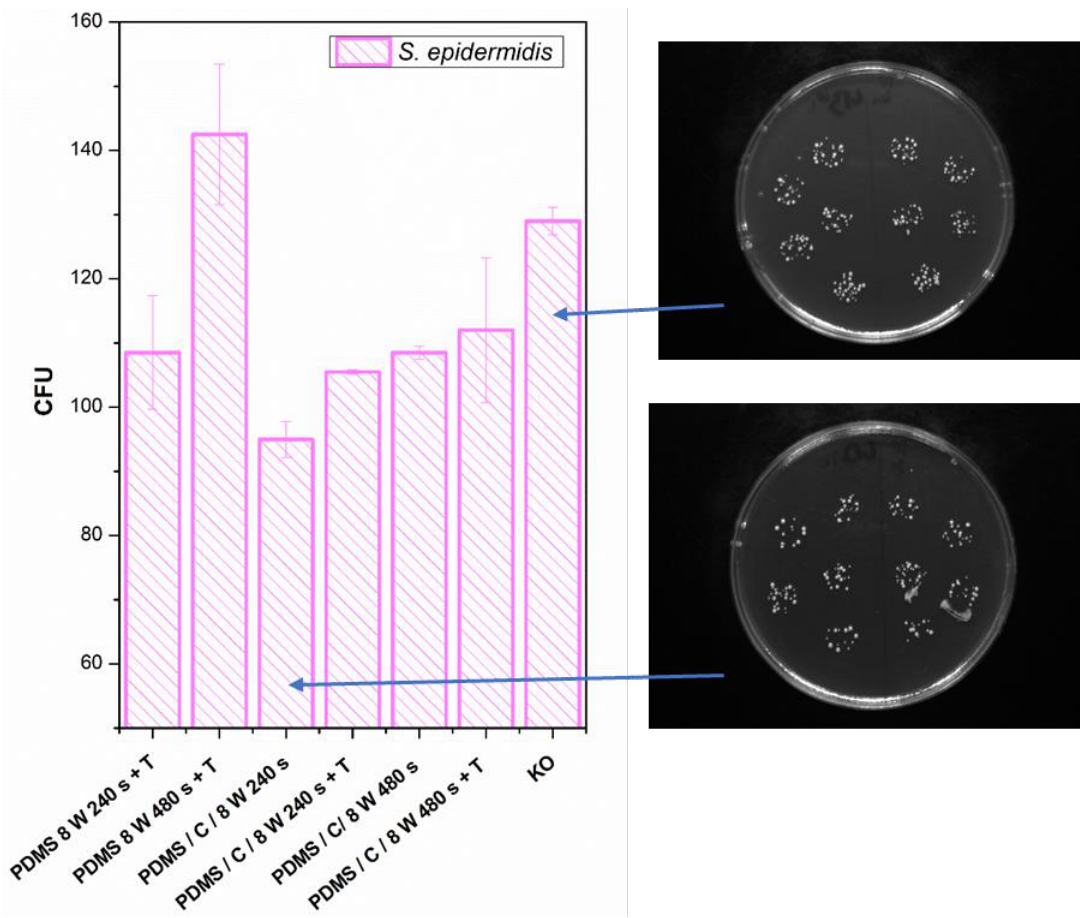
Figure 10. Antibacterial activity of polydimethylsiloxane (PDMS) samples against bacterial strains of S. epidermidis after 4 h incubation. Samples: plasma-treated PDMS with 8 W for 240 and 480 s with subsequent heat treatment (PDMS 8 W 240 s + T; PDMS 8 W 240 s + T); PDMS composite with carbon (2 wt.%) treated with plasma 8 W for 240 s (PDMS/C/8W 240s) and the same